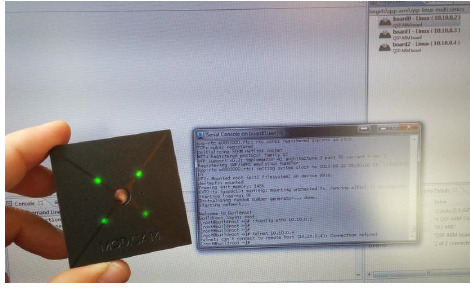
Figure 5. Node of the sensor